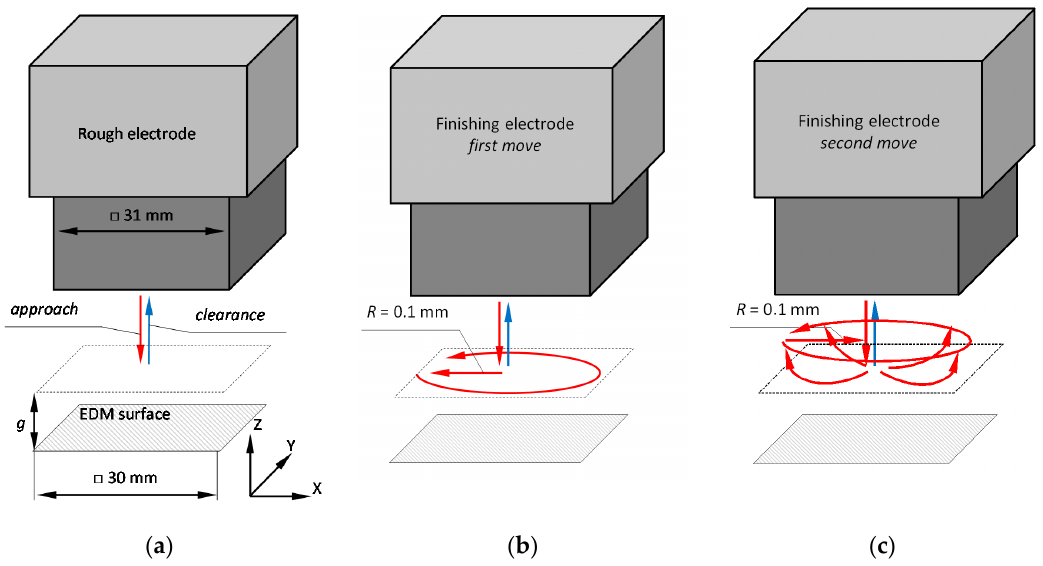
Figure 2. Experiment: ( a ) rough EDM; ( b ) finishing EDM—first move; ( c ) finishing EDM—second move.